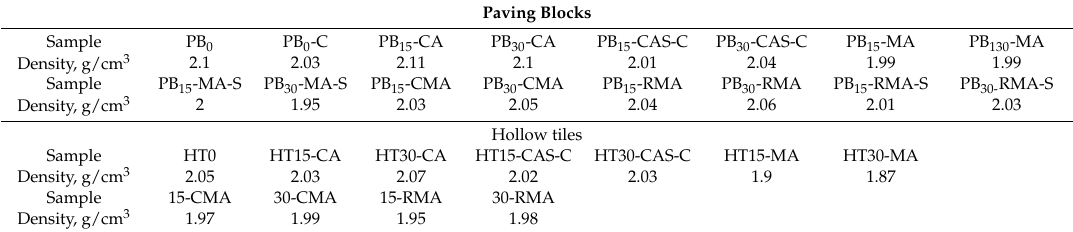
Table 11. Results of density at 28 days for paving blocks and hollow tiles, as a function of the aggregate type, and dosaging method (see Table 5 for